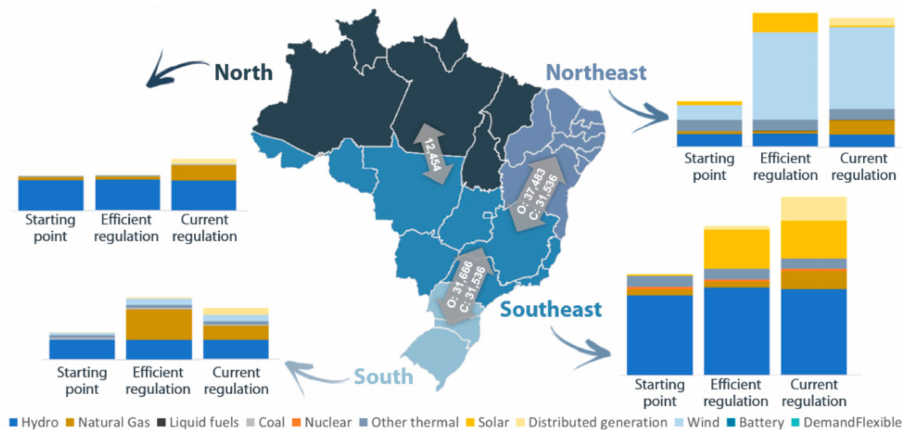
Figure 10. Comparison of the regional expansion between scenarios.